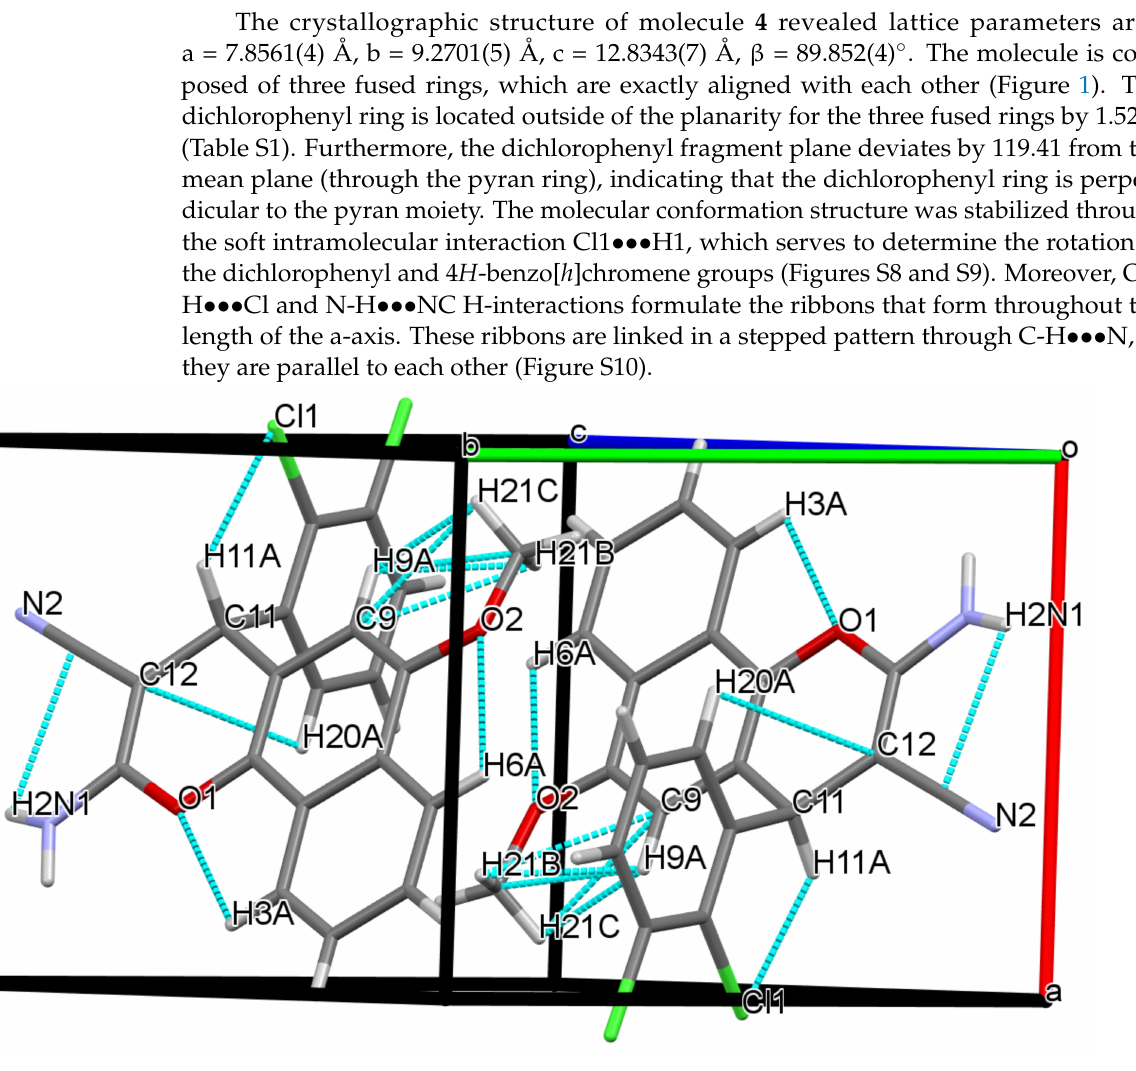
Figure 1. The H-bonded chain viewed along the b-axis direction. OC-H ••• Cl and N-H ••• NC are represented in blue dashed